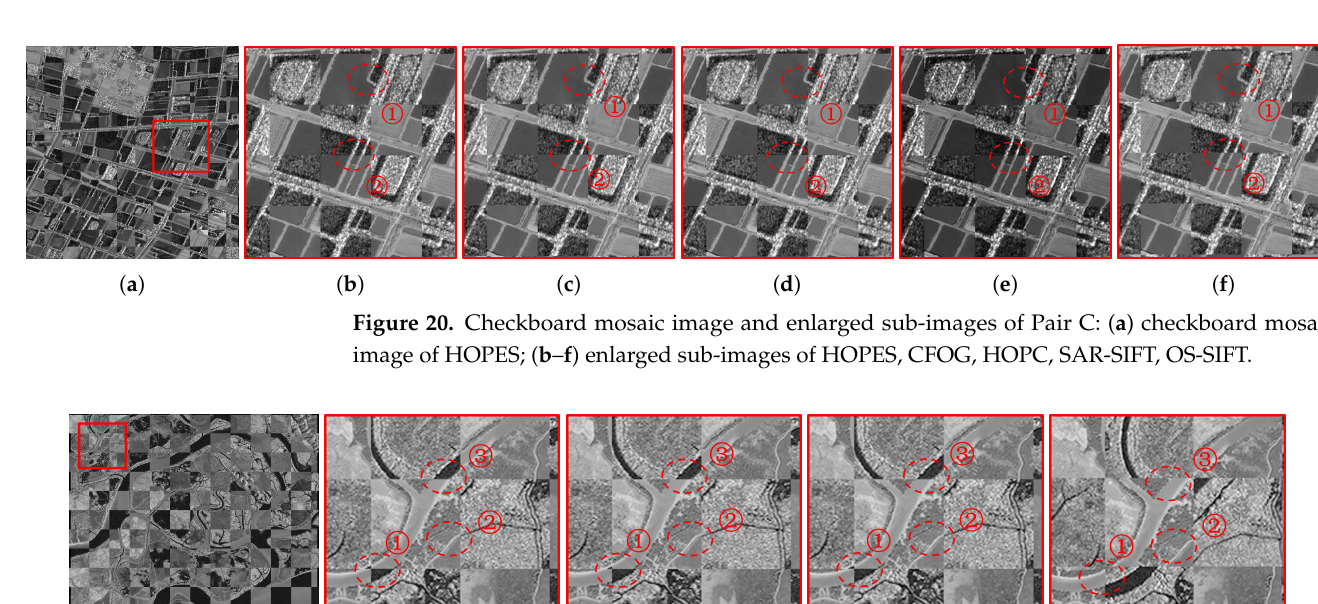
Figure 19. Checkboard mosaic image and enlarged sub-images of Pair B: ( a ) checkboard mosaic image of HOPES; ( b – d ) enlarged sub-images of HOPES, CFOG, HOPC.